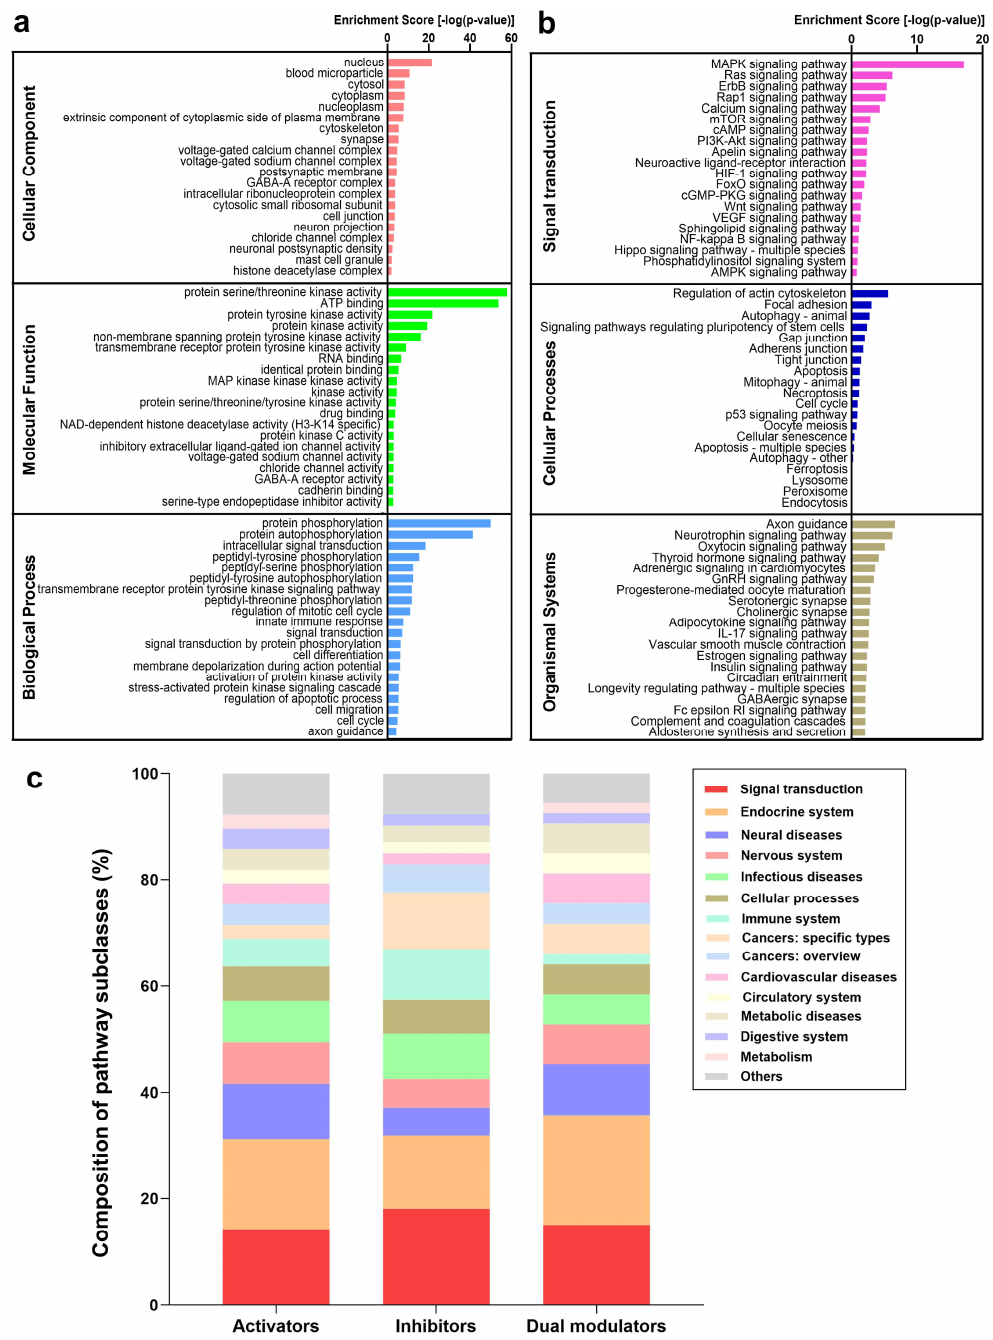
Figure 4. Gene ontology (GO) annotation and pathway enrichment analysis results based on the targets of autophagy modulators. ( a ) Enriched GO annotation terms; ( b ) Enriched KEGG pathways; ( c ) most common pathways in which autophagy targets take part. The distribution of pathway subclasses targeted by autophagy modulators are shown for each category of autophagy modulators. Note the dominance of signal transduction ( red ) and endocrine ( orange ) systems in all categories, the important association of inhibitors with cancers and, to some extent, infectious diseases, and the preferential use of activators and dual modulators in treating neural